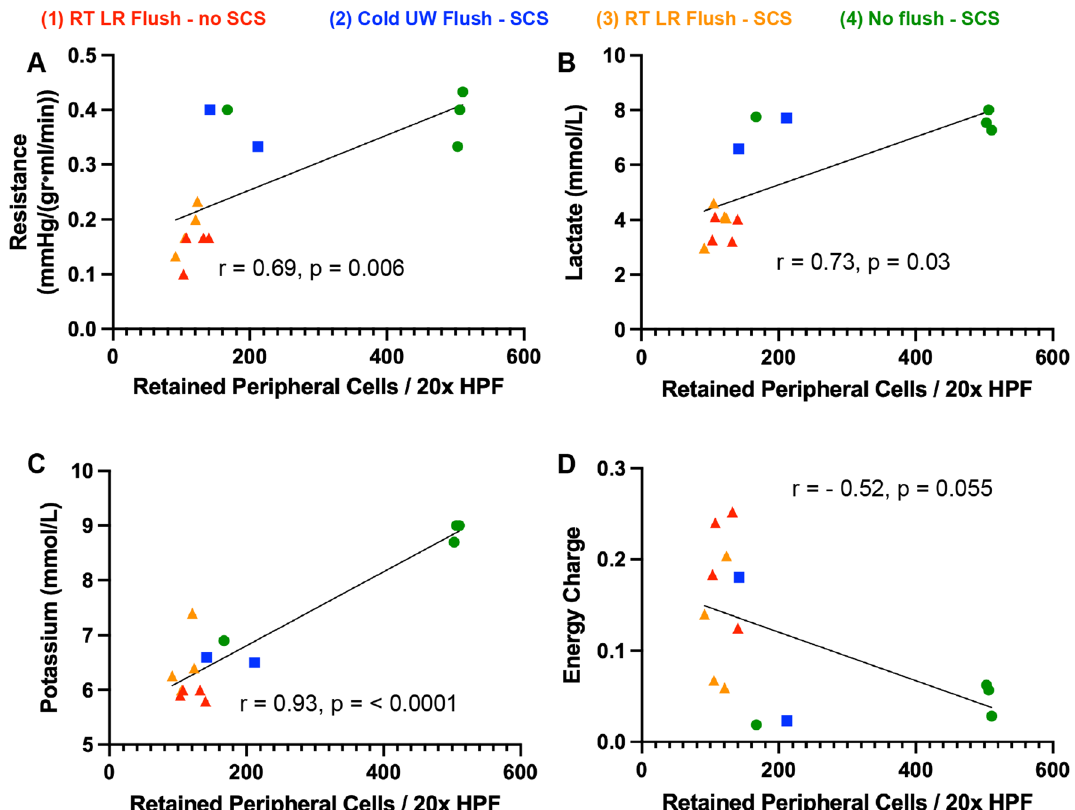
Figure 5. Correlations (r) between retained peripheral cells (RPCs) per 20 high powered fields (HPF) and corresponding perfusion parameters of liver function/injury. Red: RT LR flush livers with no SCS (n = 4). Blue: cold UW flush livers with SCS (n = 2). Orange: RT LR flush livers with SCS (n = 4). Green: No flush livers with SCS (n = 4). Black lines: fits of linear regression with 1,12 degrees of freedom (DFn, DFd). ( A ) Intrahepatic resistance, ( B ) lactate, ( C ) perfusate potassium, and ( D ) energy charge at 6 h of NMP versus RPCs within liver graft at 6 h of NMP. Significance level p <